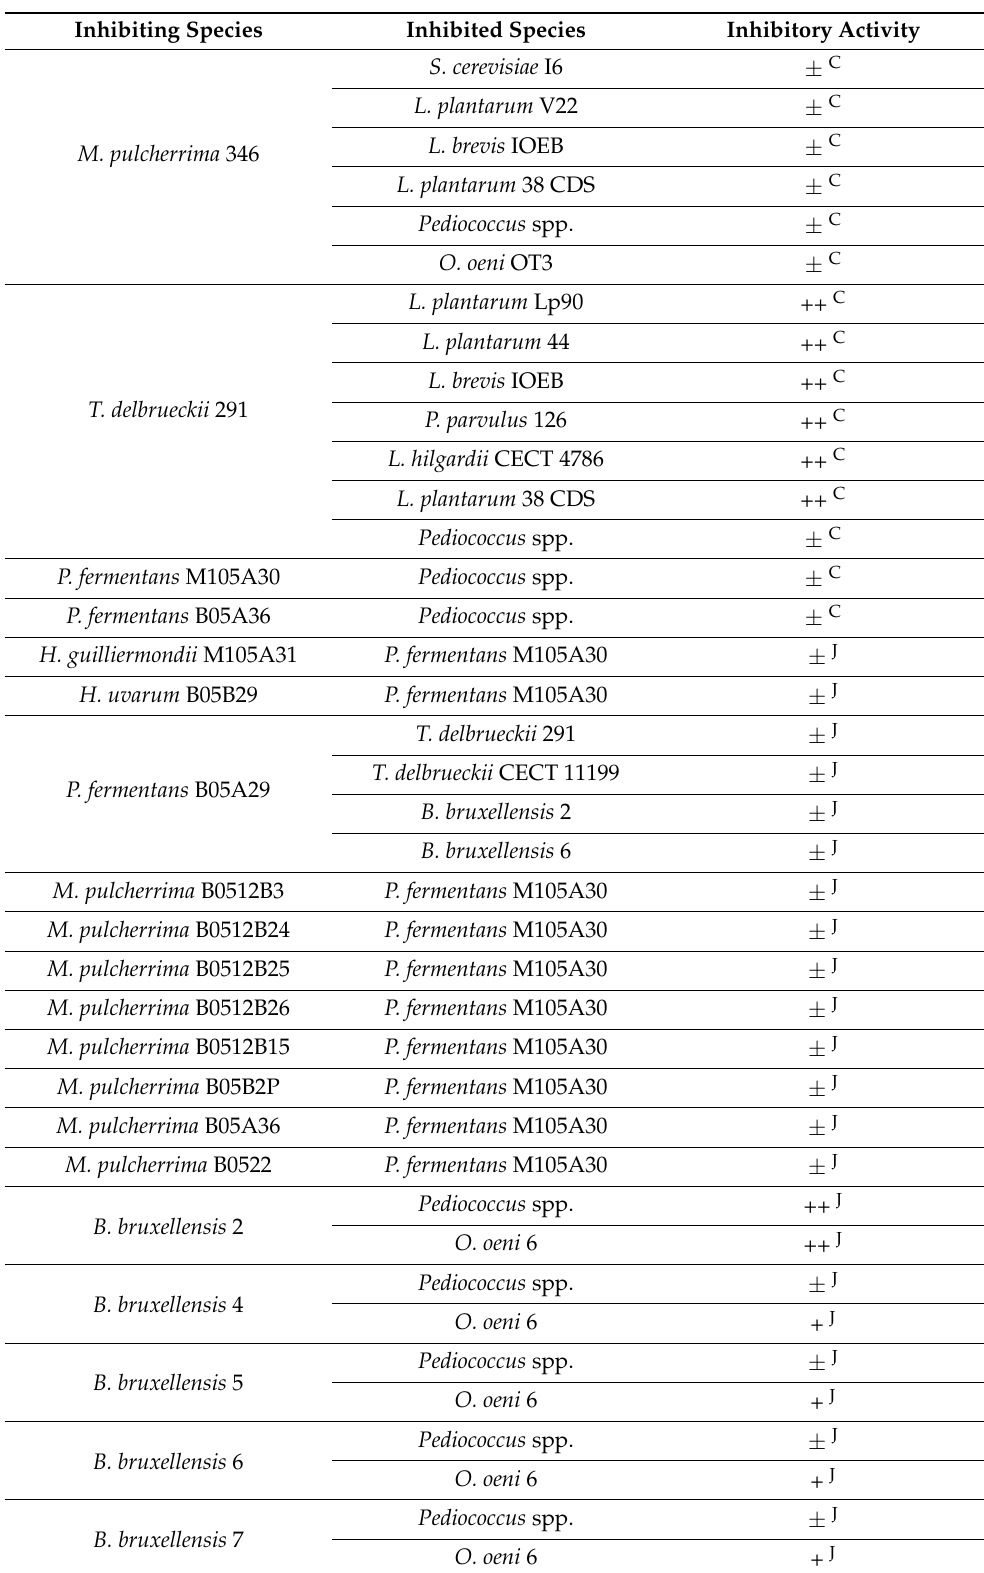
Table 2. Inhibitory activity of non- Saccharomyces yeasts according to the diameter of halo of inhibition: “ ± ” = lower than 3 mm, “+” = ranging from 3–6 mm and “++” = more than 6